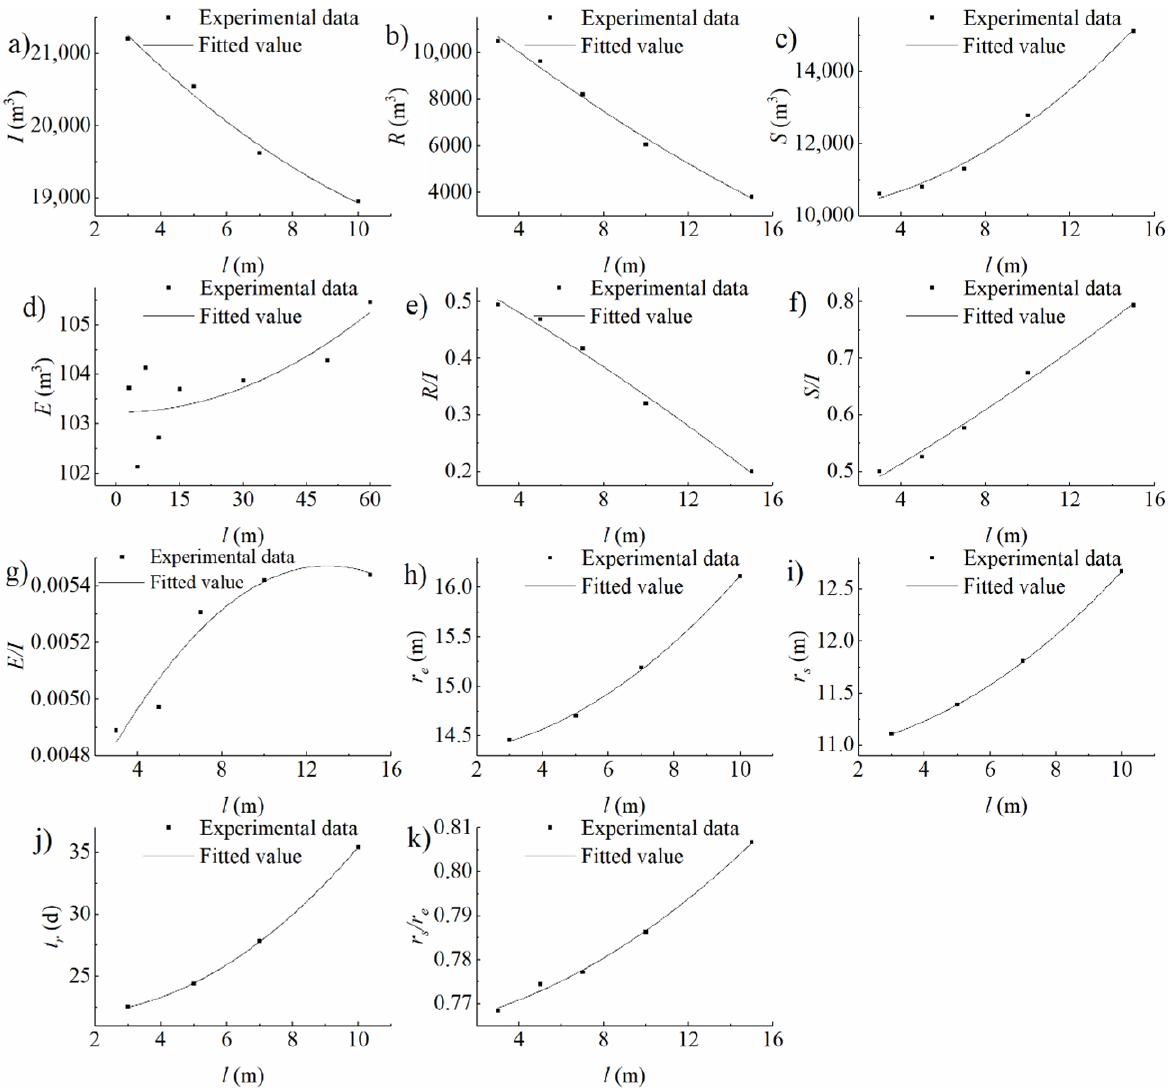
Figure 9. The variations with an increment in l when the depth is 10 m. (( a ) variation of I; ( b ) variation of R; ( c ) variation of S; ( d ) variation of E; ( e ) variation of R/I; ( f ) variation of S/I; ( g ) variation of E/I; ( h ) variation of r e ; ( i ) variation of r s ; ( j ) variation of t r ; ( k ) variation of r s /r e .).